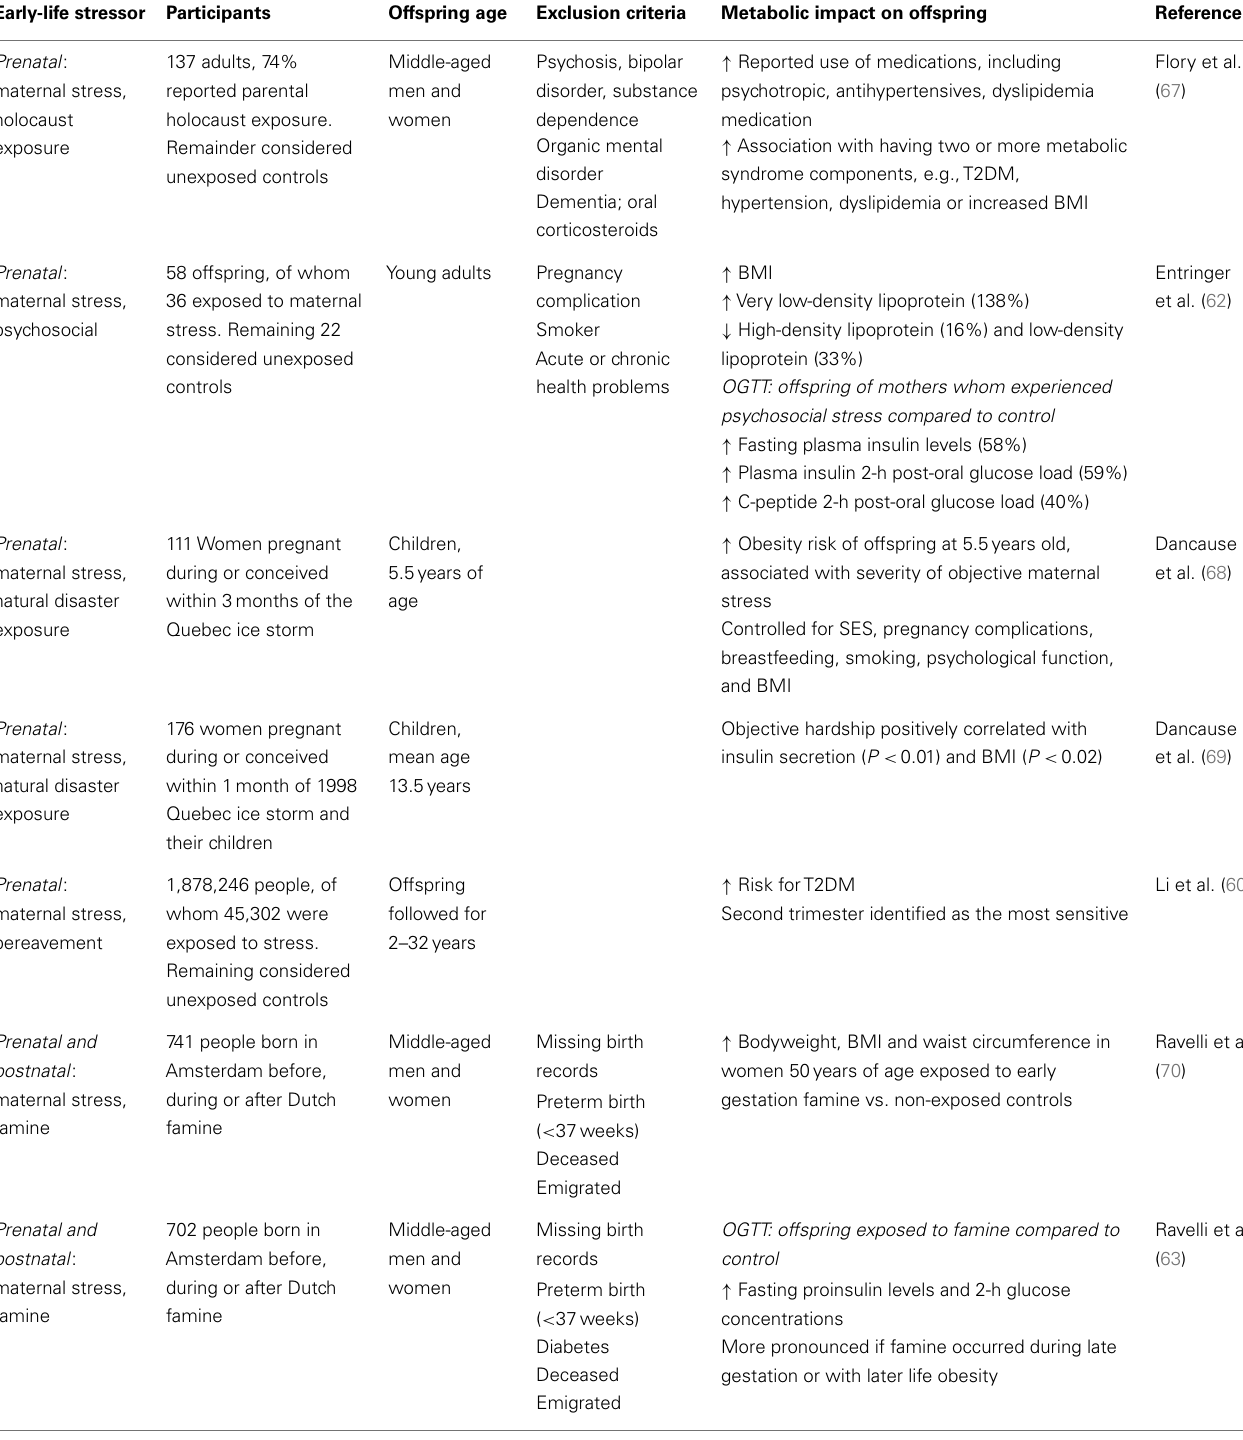
Table 1 | Human early-life stress studies exploring metabolic outcomes